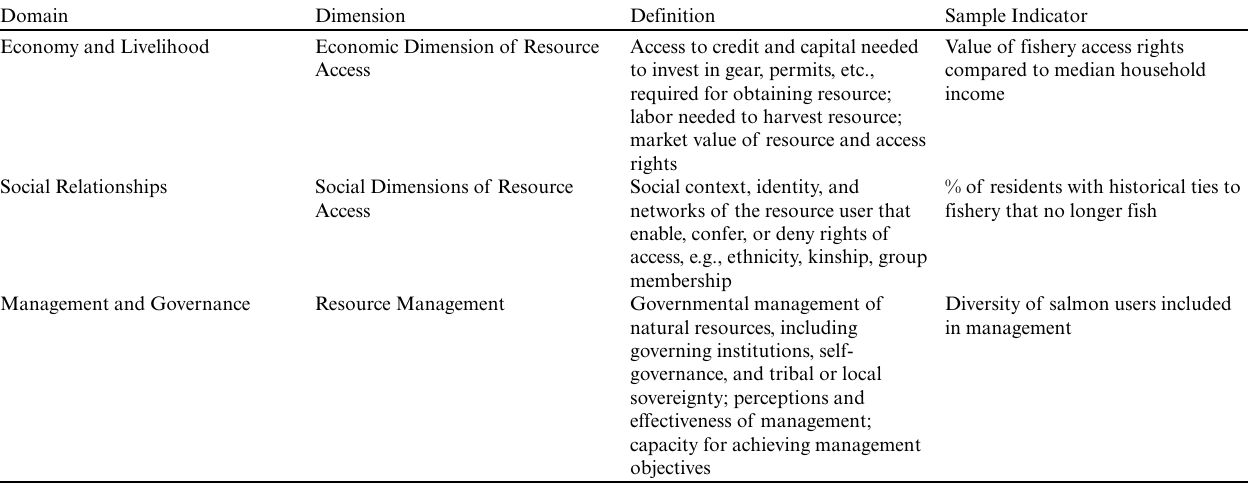
Table 1 . Examples of sample well-being indicators identified by State of Alaska’s Salmon and People working